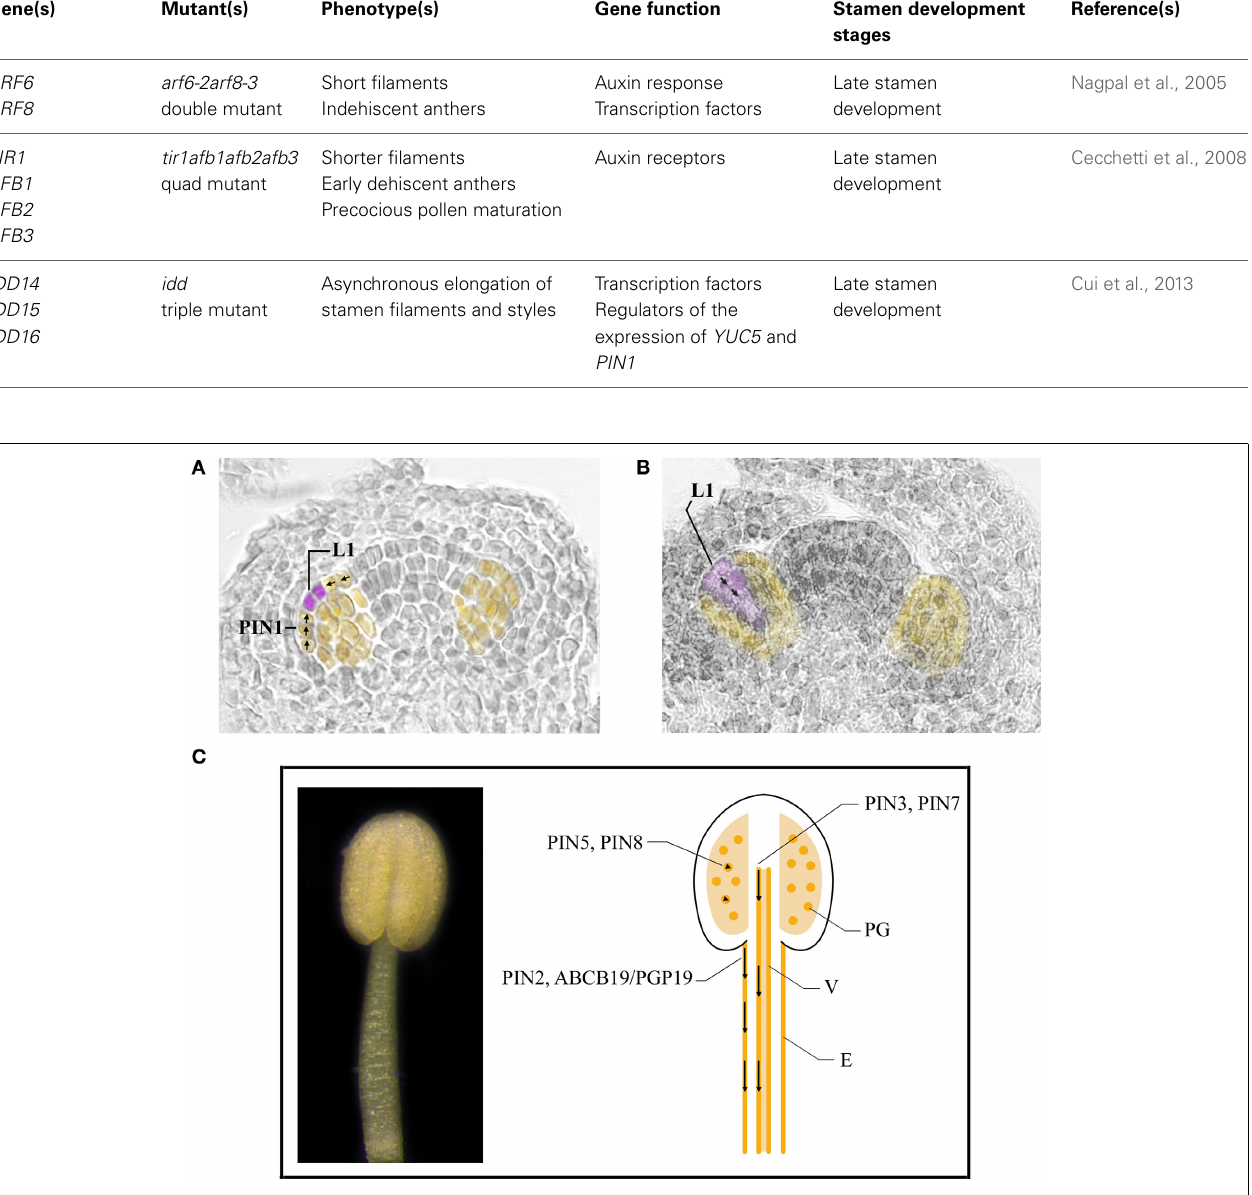
longitudinal section of a stamen at stage 11 of flower development (right). Basipetal auxin transport in the stamen filament is depicted by black arrows in epidermal cells and vascular tissue. Arrowheads indicate regulation of auxin homeostasis inside pollen grains. E, epidermal cells; L1, L1 layer; PG, pollen grains; V, vascular